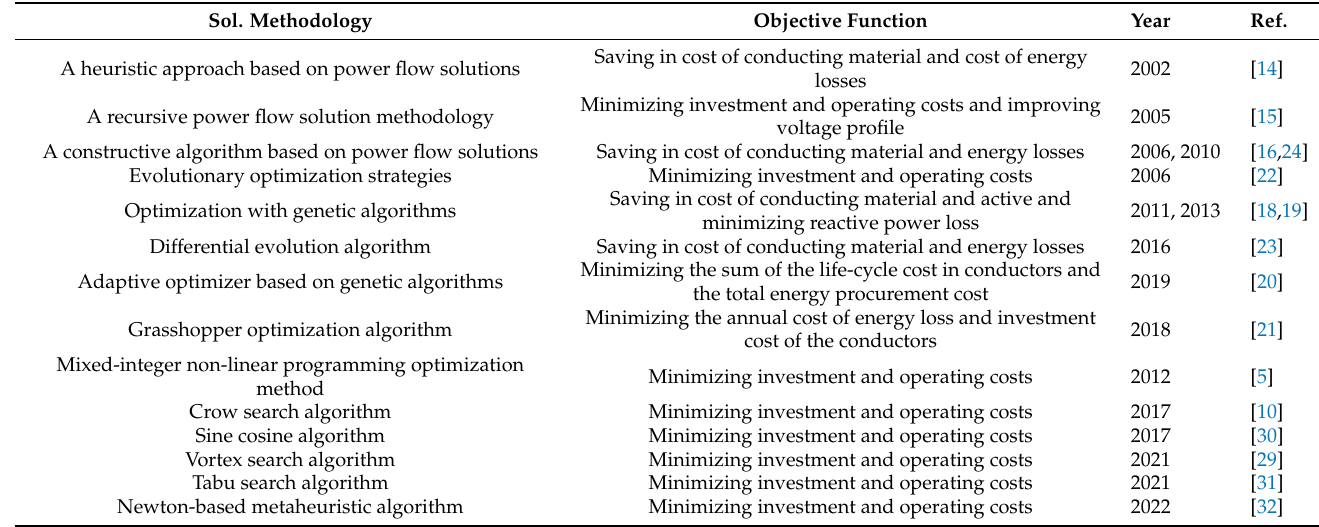
Table 1. Summary of the literature approaches used in the optimal selection of conductors for electrical distribution